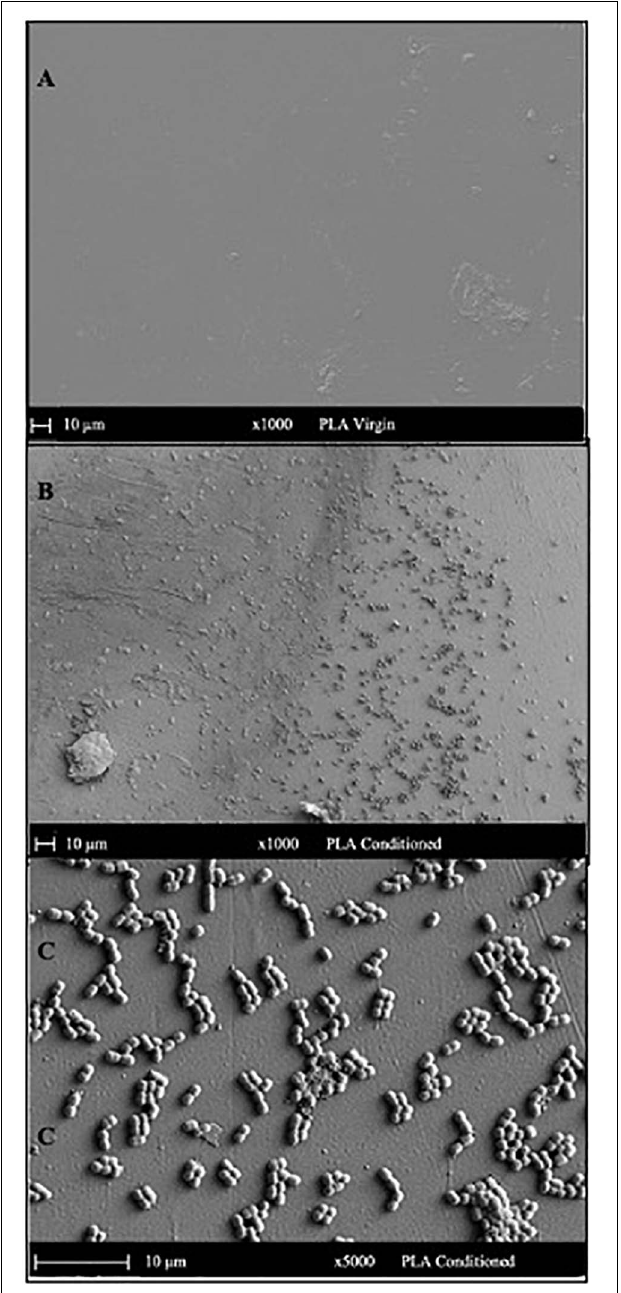
FIGURE 6 | SEM images indicating the surface morphology of the (A) virgin PLA and (B,C) conditioned PLA cards in natural seawater. The surface of conditioned plastic shows the attachment of coccoid-shaped bacterial cells after 24 h of immersion in natural seawater at 22 ◦